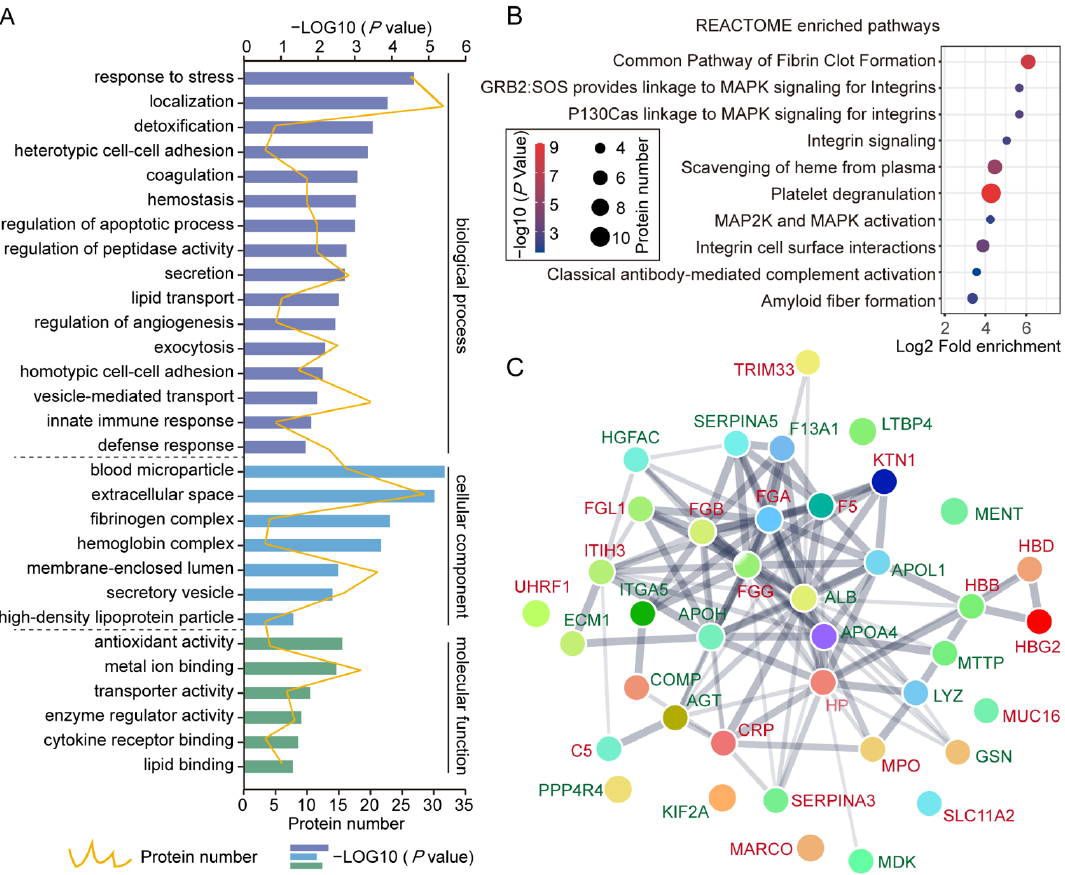
Figure 4. Functional enrichment of DEPs. ( A ) Functional classification chart of DEPs under three GO categories (biological process, cellular component, and molecular function). The yellow wavy line represented the number of proteins enriched to each function, and the bar chart represents the values of statistical p ‐ values enriched by each function after LOG10 conversion. ( B ) The above 42 DEPs were included in KEGG pathways analysis; the horizontal axis represents the values of fold change by each pathway after LOG2 conversion, the colored scale bar represents the values of statistical p ‐ values enriched by each function after LOG10 conversion, and the black circles represent the number of proteins enriched to each pathway. ( C ) The protein interaction network of DEPs. Protein ‐ to ‐ protein connections were shown in solid lines, and line thickness indicated the strength of data support. The medium confidence was 0.40.